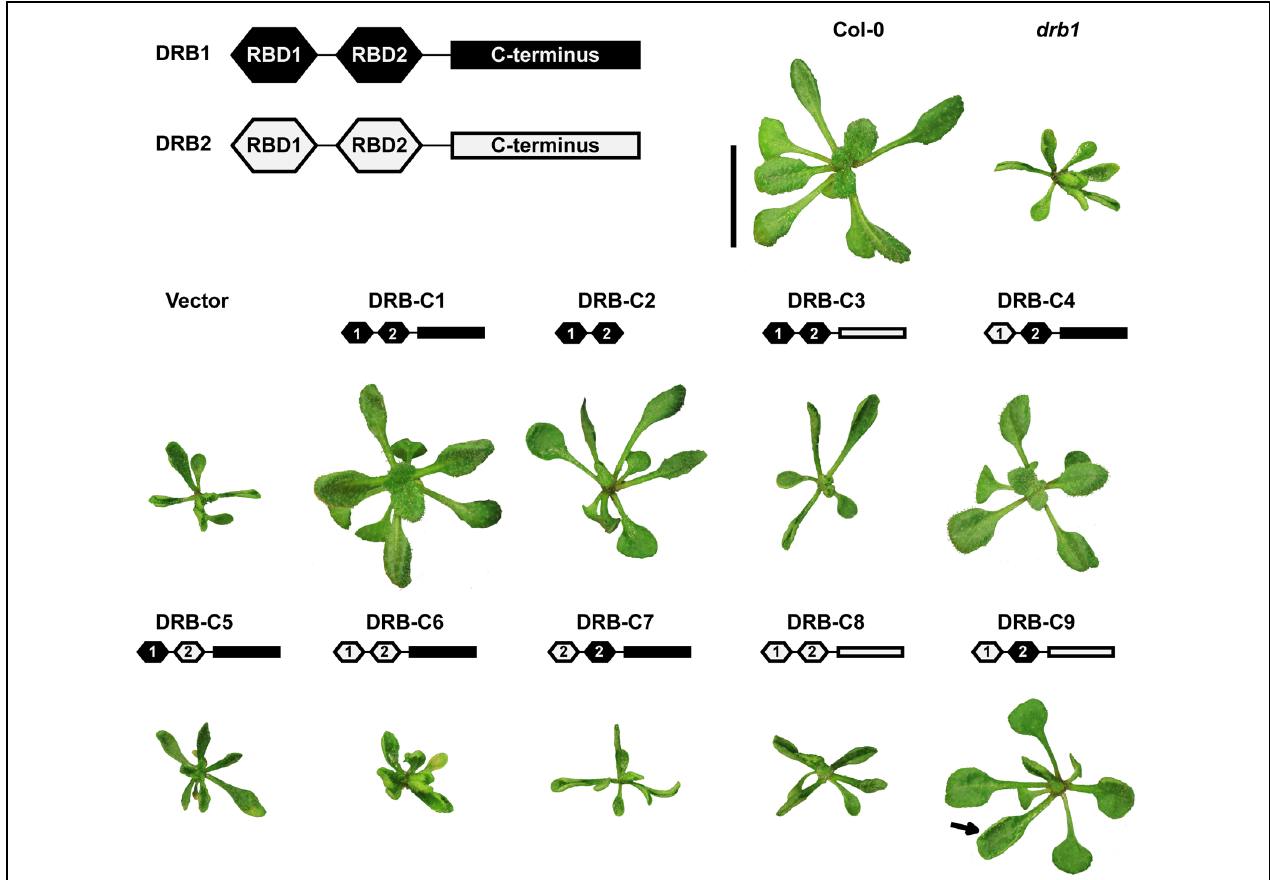
FIGURE 1 | Phenotype and ABA response of wild-type, drb1 and transgenic plants. Col-0 wild-type, drb1 , and drb1 transformed with either DRB1 (DRB-C1), dsRNA binding domains of DRB1 (DRB-C2), or a chimeric gene (DRB-C3 to DRB-C9), driven by the endogenous promoter sequence of Arabidopsis DRB1 . Protein domains of DRB1 and DRB2, used to construct the vectors for transformation, are depicted in the boxed schematic (top), and domain identities of each vector are shown above each transgenic plant. The arrow (DRB-C9) points to a drb1 -like hyponastic leaf. Transgenic plants were cultivated on MS medium under long-day conditions for 16 days. Scale bar, 50 mm. Approximately 10 homozygous transgenic plants were analyzed for each construct. All transgenic plants expressing the empty vector or DRB-C3, C5-C8 failed to complement the drb1 phenotype. Transgenic plants expressing DRB-C1, C2, C4, and C9 showed wild-type phenotype in 10 out of 10 plants (10/10), 9/9, 9/10, 9/11,